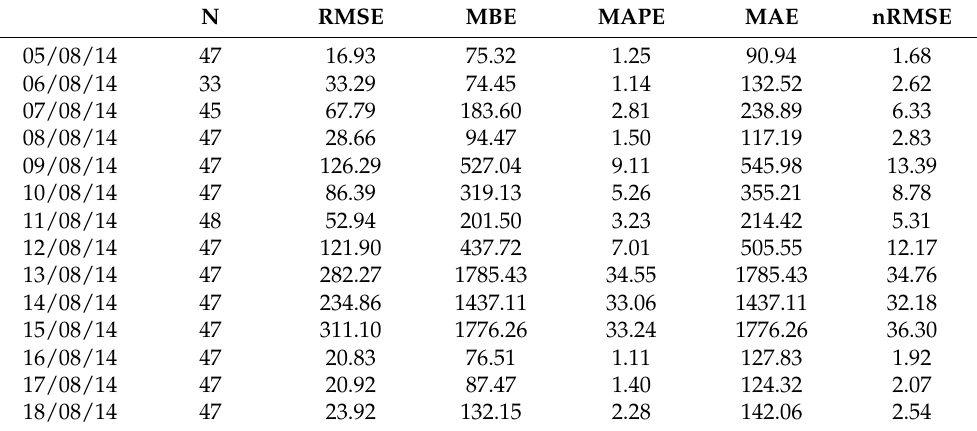
Table 7. Statistical metrics of the deviation between two inverters of the same PVS during June of 2014 for normal operation. N RMSE MBE MAPE MAE